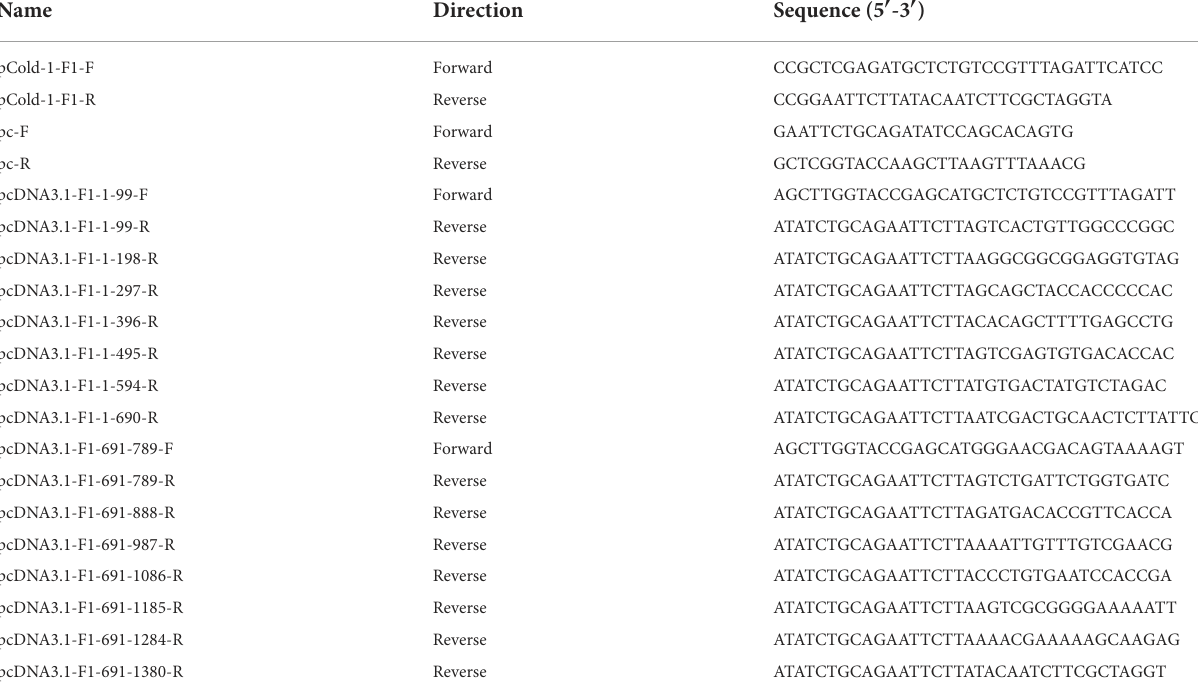
TABLE 1 Primers for amplifying the linear plasmid, fiber-1 gene and its